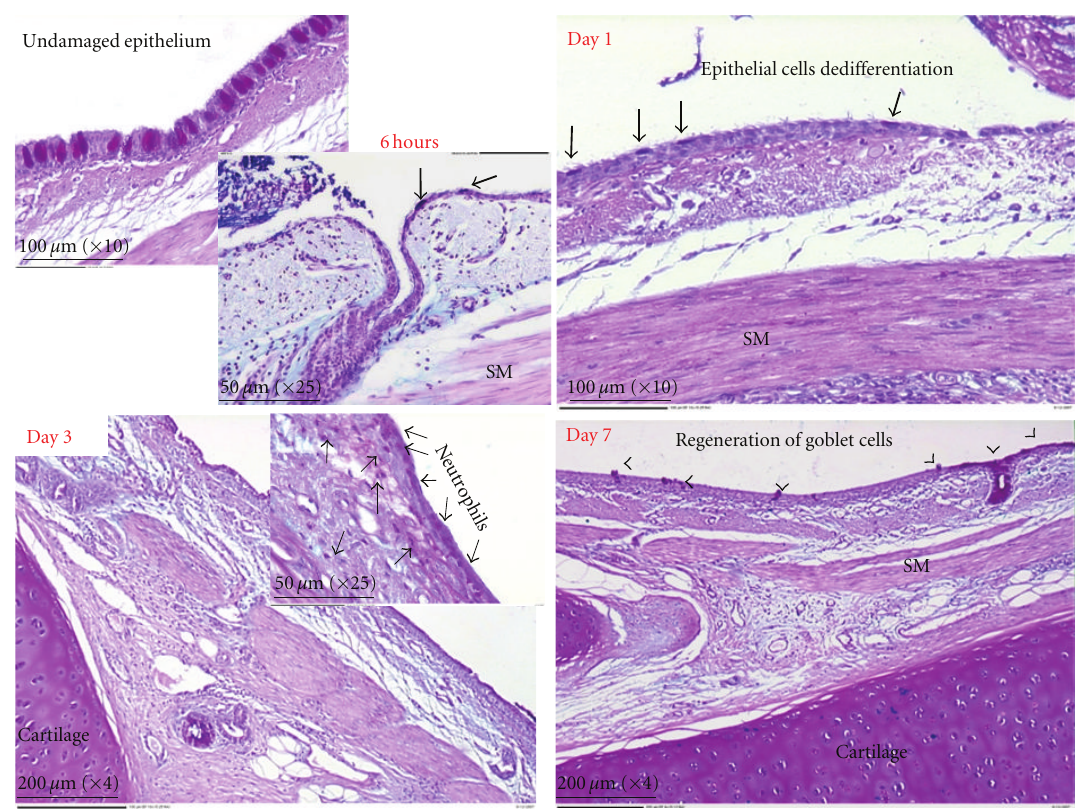
Figure 2: In the normal airways (undamaged), goblet cells were clearly stained with AB-PAS staining (top left panel). At six to twenty- four hours after-injury, PAS-positive cell is no longer retained the characteristic morphology of goblet cells but rather were attenuated in appearance (top right panel; thick arrows) indicating potential epithelial dedi ff erentiation. By day 3 after-injury, a layer of positive AB-PAS staining was observed overlying the repairing epithelial surface. Closer examination determined that the layer was comprised of a dense and compact accumulation of neutrophils held within and below the mucin layer (bottom left panel; thin arrows). By day 7 after-injury regenerating goblet cells could be seen incorporated in the epithelium overlying the brushed site (bottom right panel; arrows head) an observation taken to imply epithelial redi ff erentiation was underway. (SM = smooth) [88]. that a fully functional airway epithelium can be completely